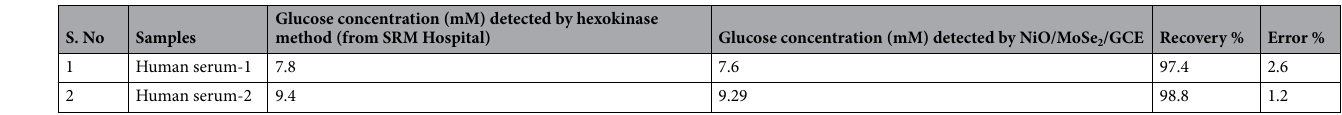
Table 2. Determination of glucose in human blood serum samples by using a NiO/MoSe 2